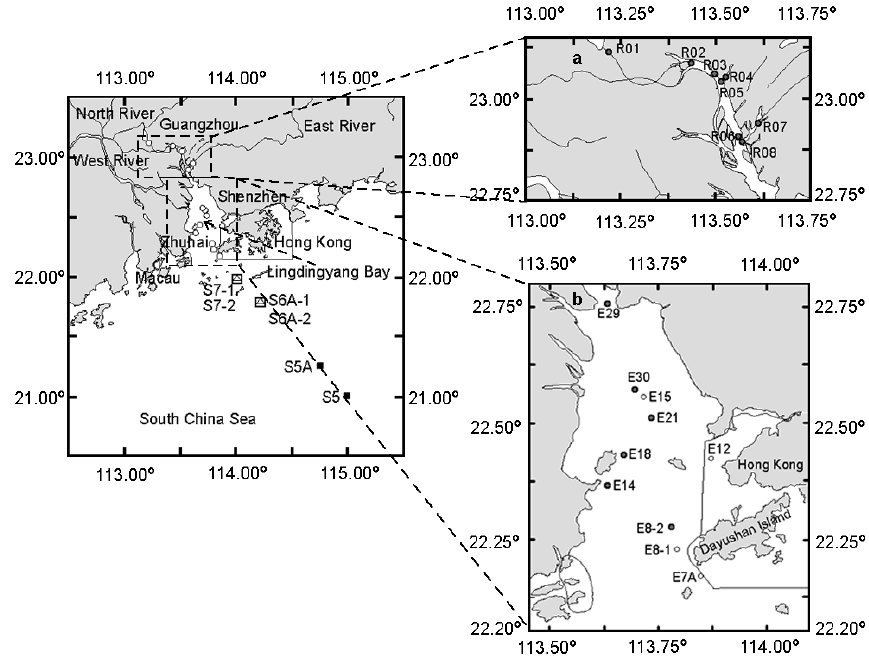
Fig. 1. Map of the Pearl River Estuary and the adjacent South China Sea (SCS) shelf showing the sampling stations: (a) in the upper reach (freshwater part) of the Pearl River Estuary; (b) in Lingdingyang Bay. The SCS shelf is defined as inner shelf (open squares) and outer shelf (closed squares) for convenience of discussion. The upper reach samples were collected in January 2005; Lingdingyang Bay and SCS shelf samples were collected in November 2002 (closed circles and squares) and May 2001 (open circle and